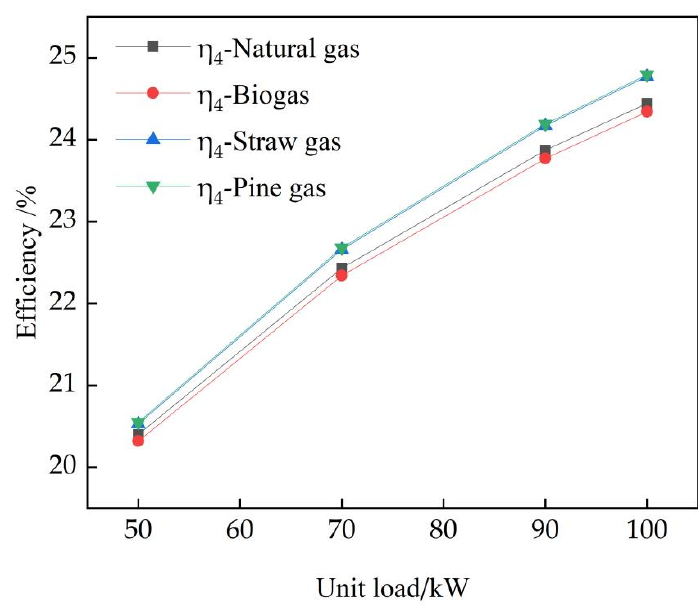
Figure 6. Partial load operation efficiency chart of gas-steam cycle.